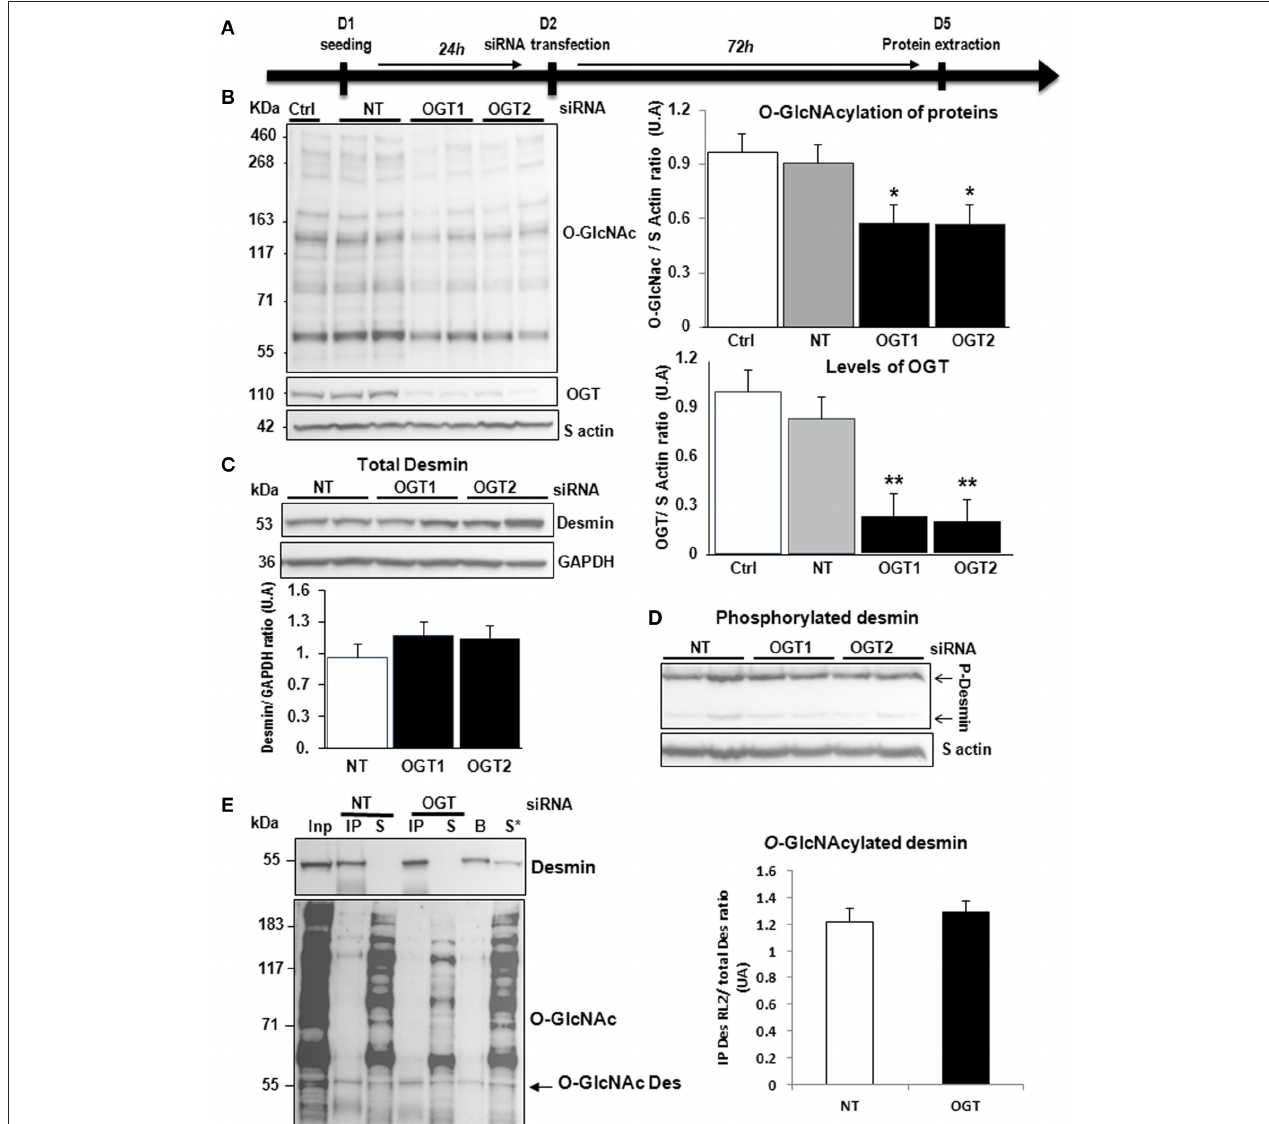
FIGURE 3 | Effect of OGT silencing in primary cultures of NCM. (A) Description of the protocol designed for OGT silencing of primary cultures of NCM. (B) Western blots (left panel) and quantification of O-GlcNAcylated proteins levels (upper and right panel) and OGT (lower and right panel) in primary cultures of NCM transfected with non-targeting (NT) siRNA control and OGT1 and OGT2 siRNA ( n = 12). (C) Western blots (upper panel) and quantification (lower panel) of total desmin levels in the same samples. (D) Phosphorylation profiles of desmin was analyzed in the same samples by Phos-tag TM gel. (E) Representative Immunoprecipitation (IP) with desmin antibody before western blot with RL2 antibody (left panel) and quantification (right panel) of O-GlcNAcylated desmin levels in the same samples. Inp, input; IP, immunoprecipitated proteins; S, IP supernatant; B, beads alone; S*, IP supernatant of beads. The arrow indicates the O-GlcNAcylated desmin. Graphs show mean ± SEM values expressed in arbitrary units (A.U.). The positions of molecular weight are indicated as kilodalton (kDa) on the left. * P < 0.005; ** P <